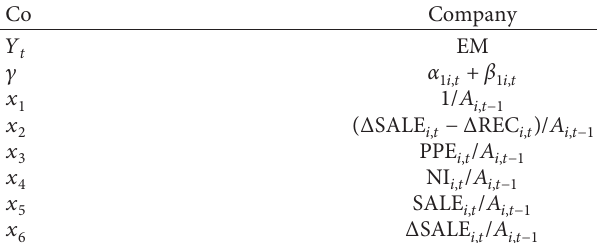
Table 1: Variable explanation.